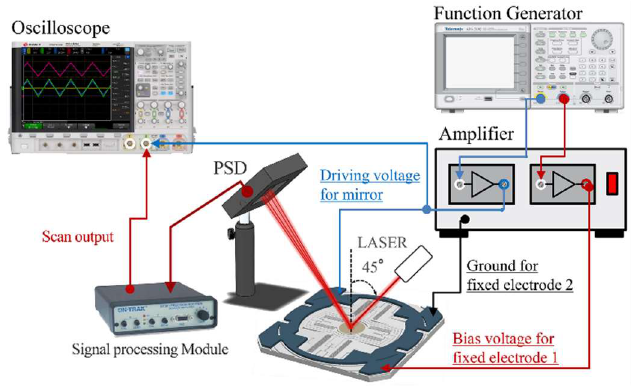
Figure 5. Experimental setup for obtaining a transfer function of the microscanner.